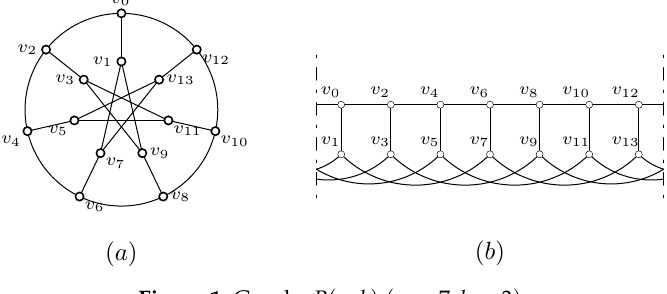
Figure 1. Graph P ( n , k ) ( n = 7, k = 3 ) . Figure 1. Graphs P ( n , k ) ( n = 7, k = 3 )